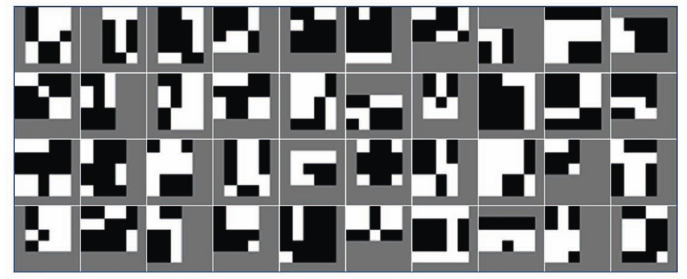
Figure 6. A number of Haar-like feature